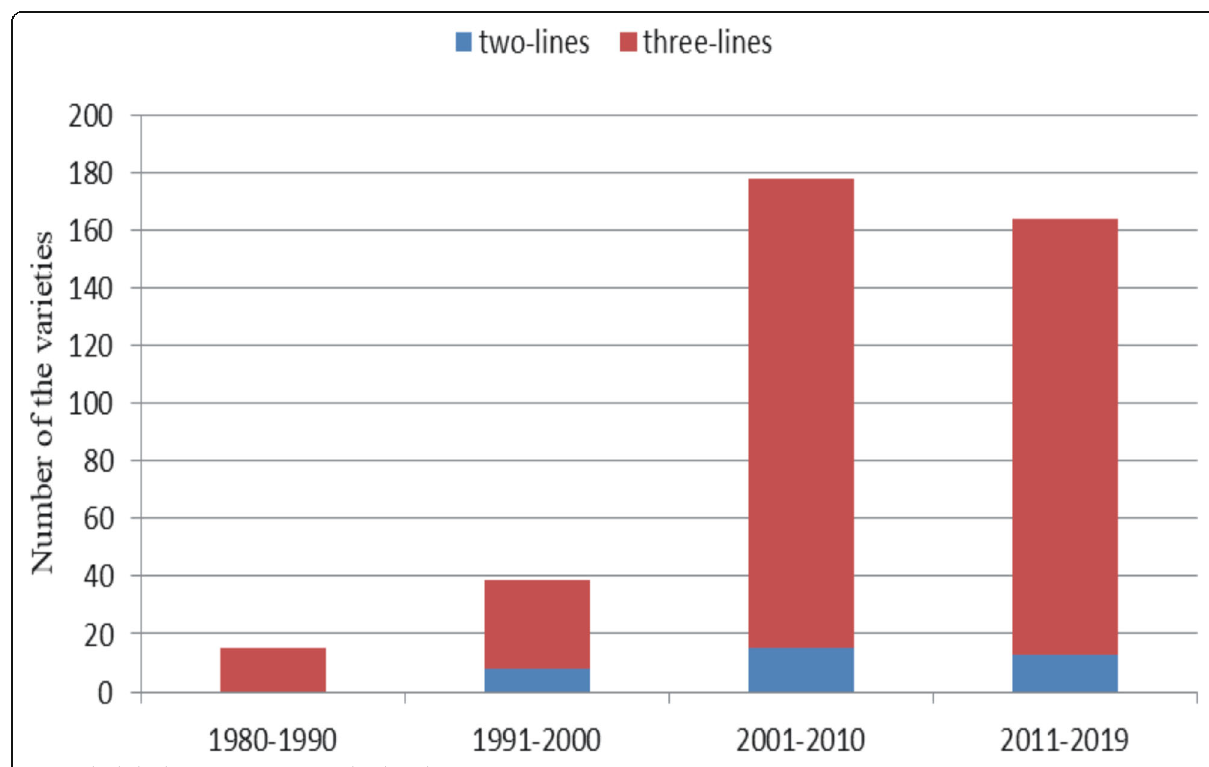
Fig. 3 The hybrid japonica rice varieties bred in